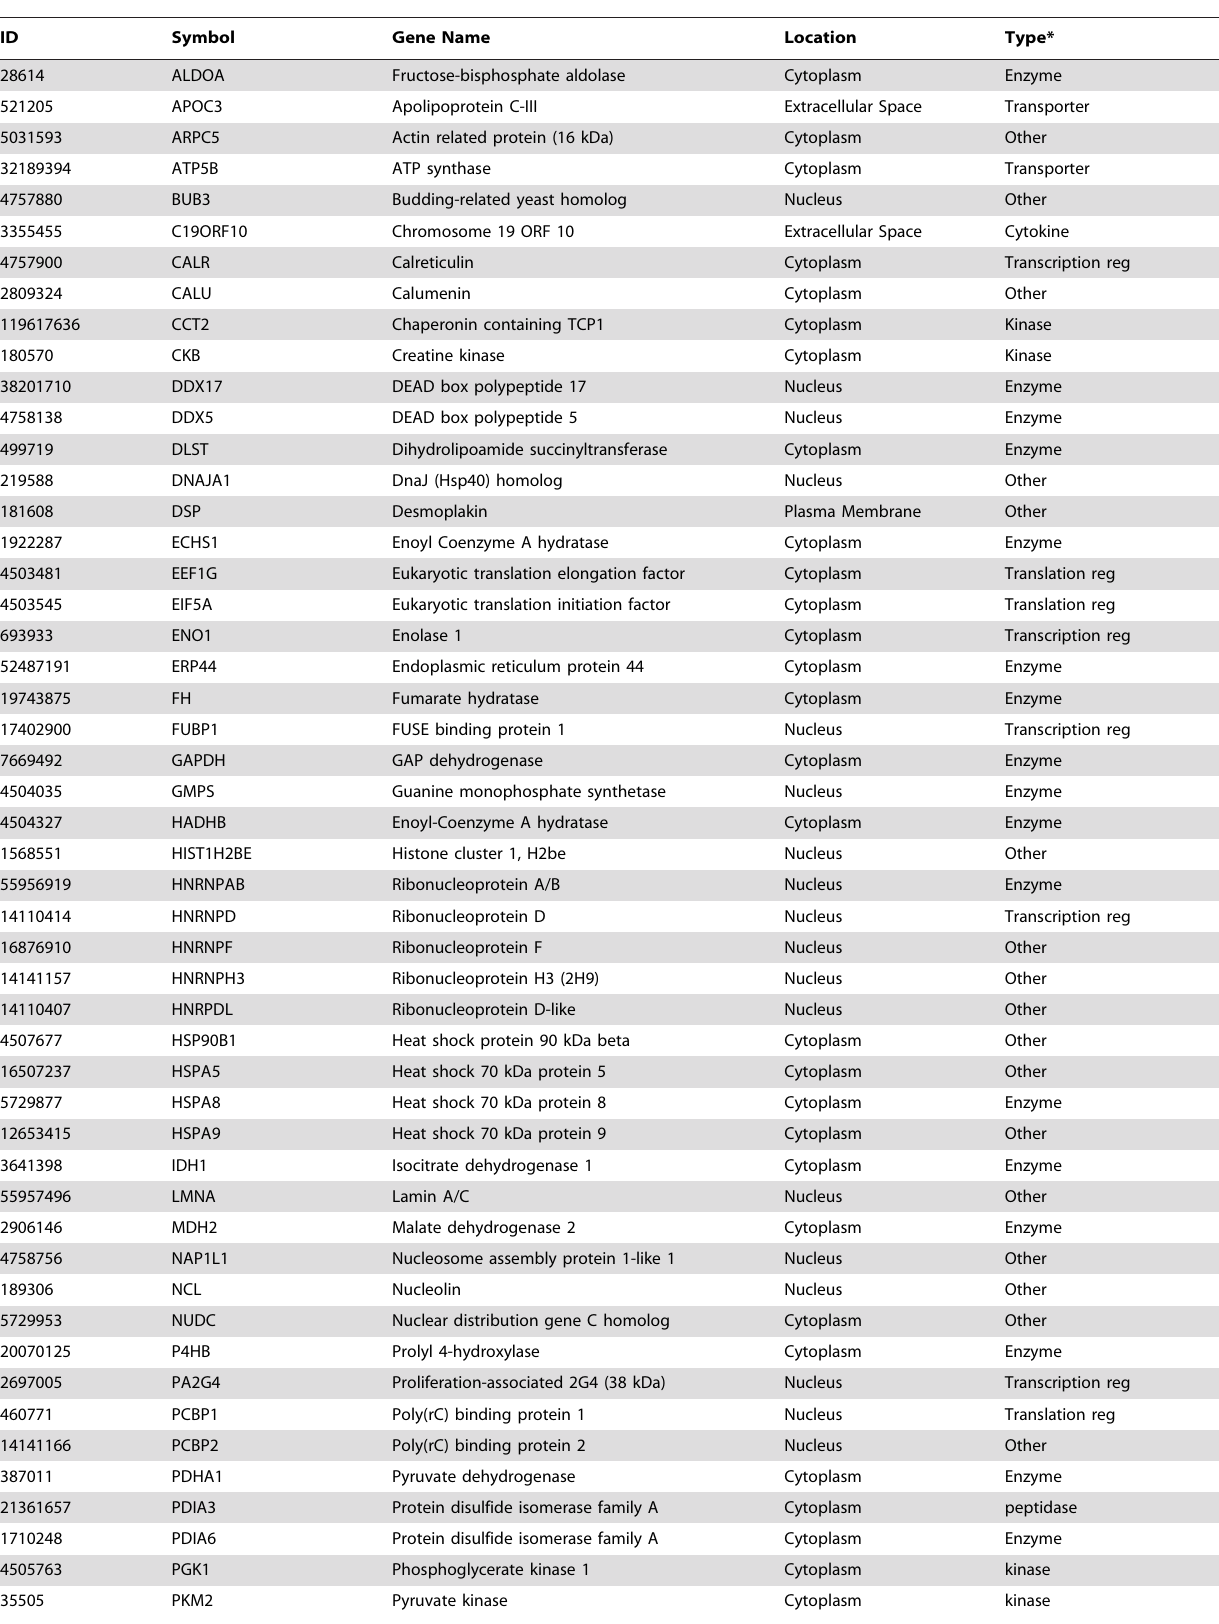
Table 3. Caco-2 cell proteins whose expression is upregulated in the presence of Campylobacter concisus UNSWCD.